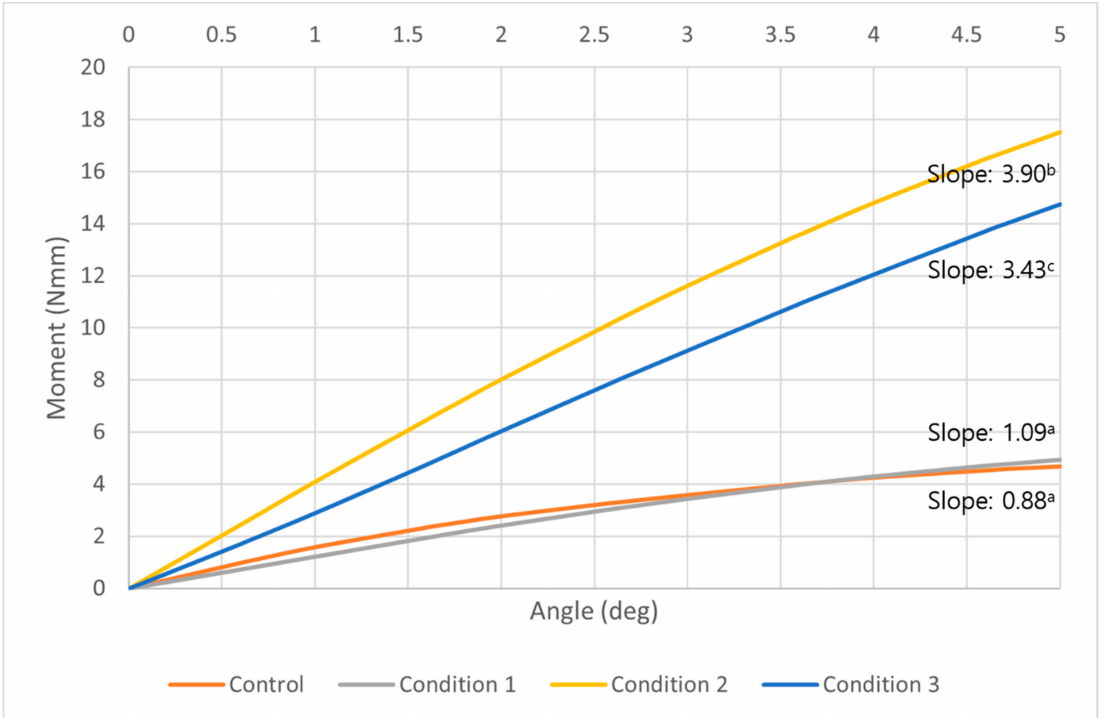
Figure 8. A graph of the moment at the middle of trabecular bone required to unwind the orthodontic miniscrew in control (orange), condition 1 (gray), condition 2 (yellow), and condition 3 (blue). At all degrees, the model with condition 2 showed the highest moment than any other conditions or the control. A model with condition 1, with the narrowed thread diameter at the upper part, showed a similar moment pattern to the control. All models including the control showed a constant increase as the angle of counterclockwise rotation increased. a,b,c Different alphabets means statistically different slopes in control and each condition ( p <